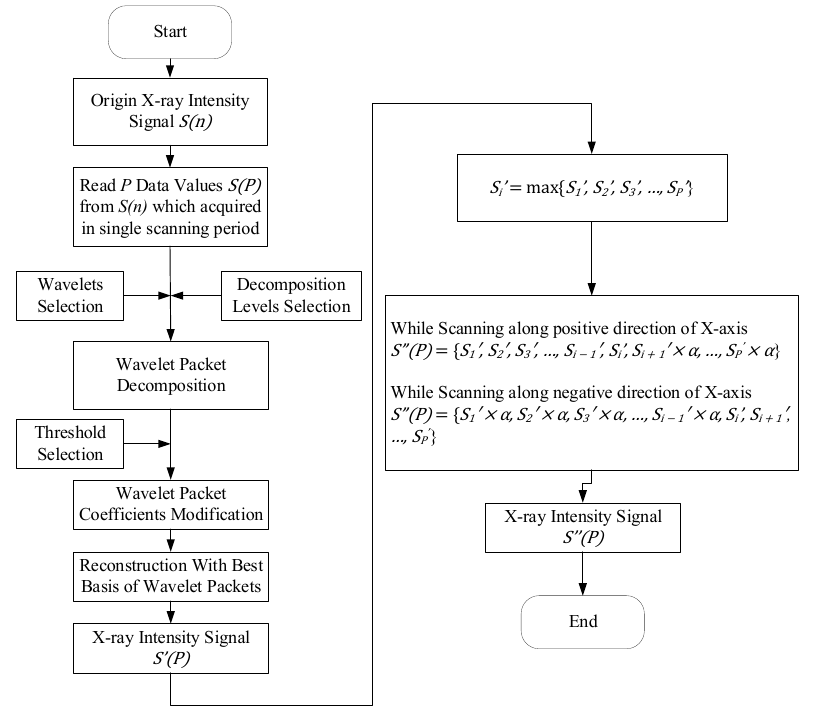
Figure 8. The flowchart of processing algorithms.